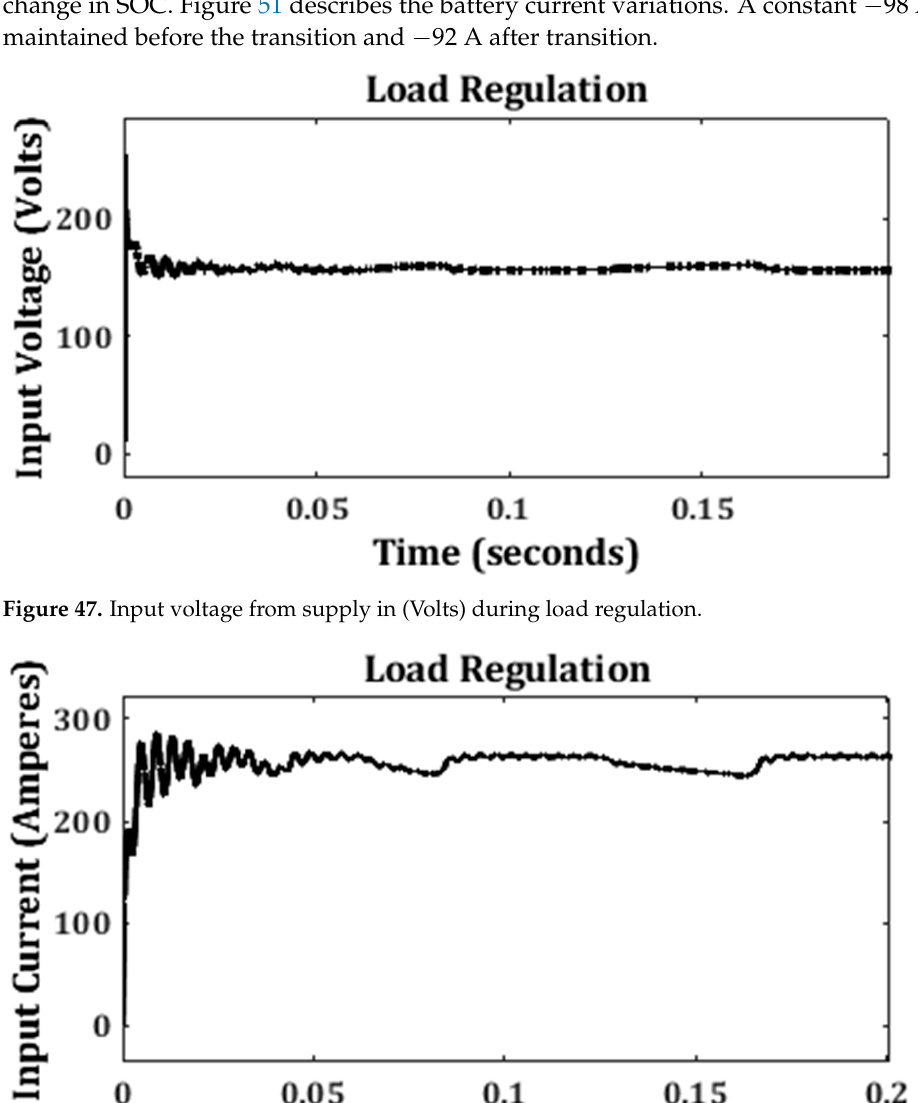
Figure 49. Battery terminal voltage in volts. Figure 50. State of charge in %.